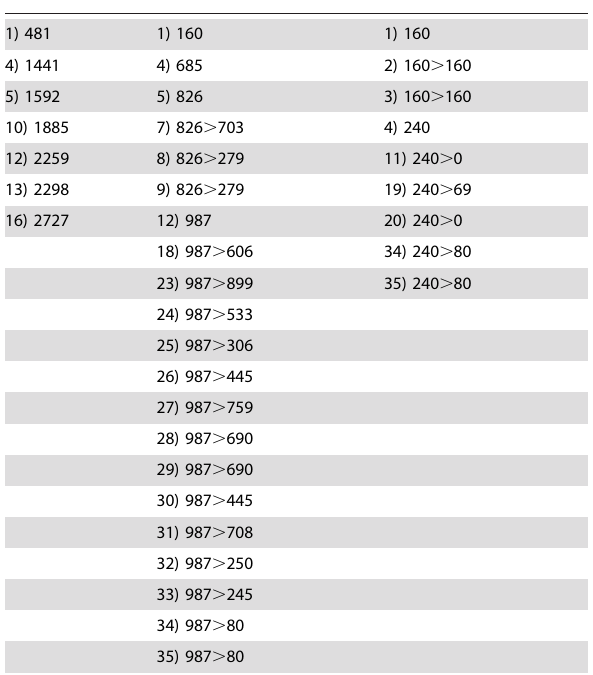
Table 3. Example GREEDY- C LC 2